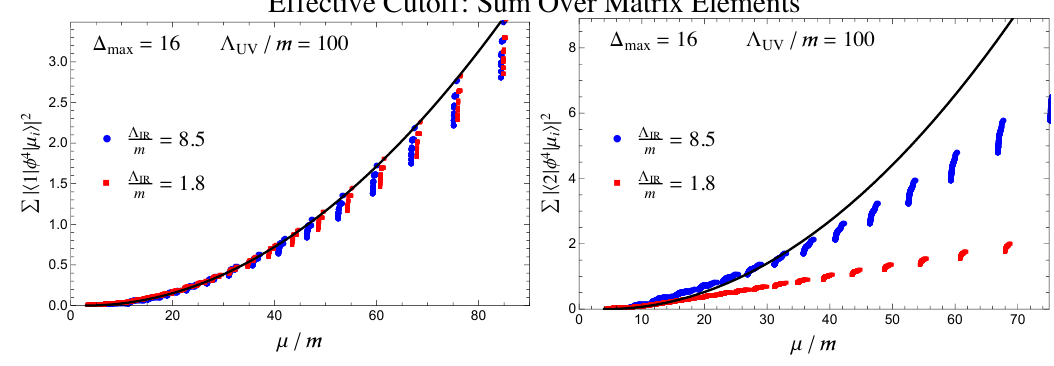
Figure 18 . Sum over intermediate matrix elements for the one-particle state (left) and lowest two-particle state (right) as a function of the intermediate invariant mass µ , for Λ and Λ = 1 . 8 (red). Both plots were made with ∆ IR /m are compared to the theoretical prediction (black